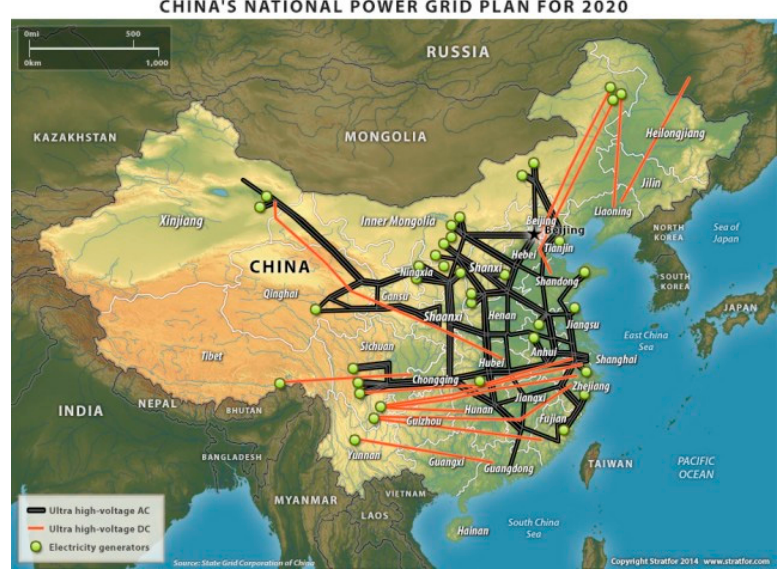
Figure 4. China’s national power grid plan for 2020. Source: Reproduced with permission from [41].